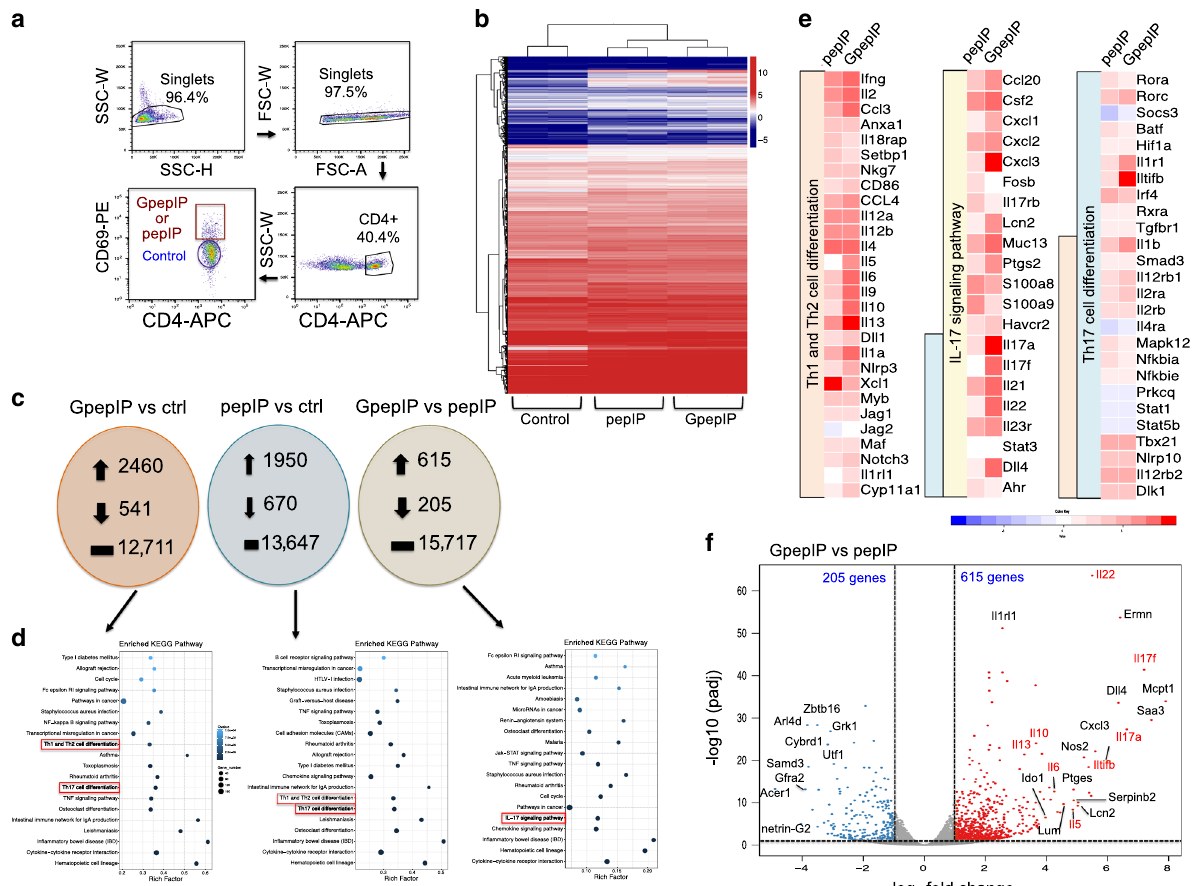
Fig. 4 Transcriptomic analysis of GpepIP-stimulated and pepIP-stimulated CD4 + T cell populations. a Gating strategy of sorting antigen-speci fi c CD4 + T cell populations by fl ow cytometry is shown. Three weeks after the third immunization with GpepIP or pepIP, splenic and lymph node cells were isolated and stimulated in vitro with GpepIP or pepIP, respectively, for 3 days. CD4 + CD69 + and CD4 + CD69 − T cell populations were then sorted by fl ow cytometry. b Dendrogram and hierarchical clustering heat map of genes from control, GpepIP, and pepIP populations. The blue and red bands indicate low and high gene expression quantity, respectively. The vertical distances between branches of the dendrogram represent the similarity of gene expression pro fi les between samples. Biological replicates showed the highest degree of correlation followed by GpepIP or pepIP stimulated populations. c The number of upregulated, downregulated, and unchanged genes in GpepIP and pepIP stimulated CD4 + T cells compared to control or to each other is shown. d KEGG pathway enrichment analysis of DEGs from each comparison. Point size indicates DEG number (the bigger dots refer to larger amount). Rich factor refers to the value of enrichment factor which is the quotient of the number of DEGs and total gene amount in that pathway. Pathways associated with Th cell differentiation were highlighted by red rectangles. e Heat map depicts the DEGs associated with Th1 and Th2 cell differentiation, IL-17-signaling pathway, and Th17 cell differentiation between GpepIP and pepIP speci fi c CD4 + T cells with normalization to control. Heatmap colors represent the log2-fold change values relative to the control. f Volcano plot showing the gene signature of GpepIP compared to pepIP-speci fi c CD4 + T cells. X- axis represents log2- transformed fold change. Y -axis represents − log10 transformed signi fi cance. Red points represent up-regulated DEGs. Blue points represent down- regulated DEGs. Gray points represent non-DEGs. Genes associated with Th cell differentiation were labeled and